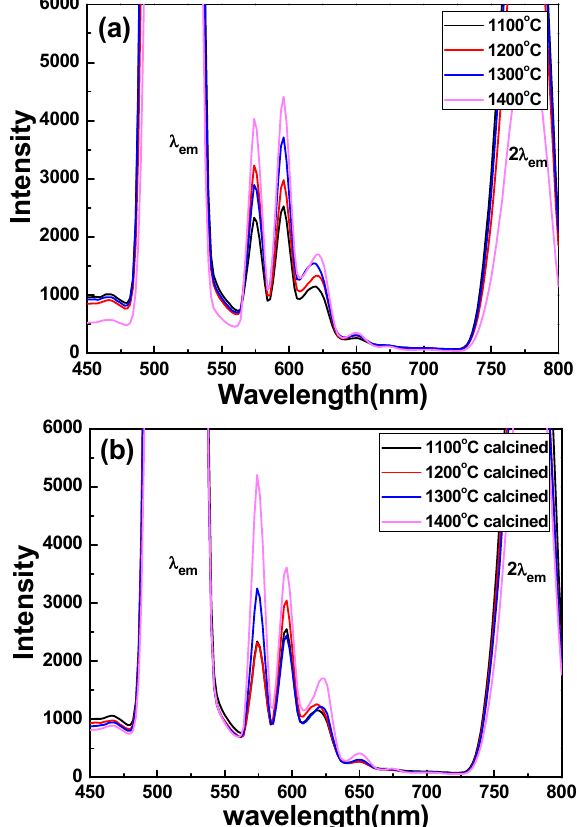
Figure 3. Emission spectrum of BaZrO 3 :Eu 0.025 powders in the light wavelength of 450–800 nm as a function of heating process and heating temperature. ( a ) One-step Eu-BZO powders and ( b ) two-step Eu-BZO powders, respectively. ( λ em : main peak of excitation spectra.)